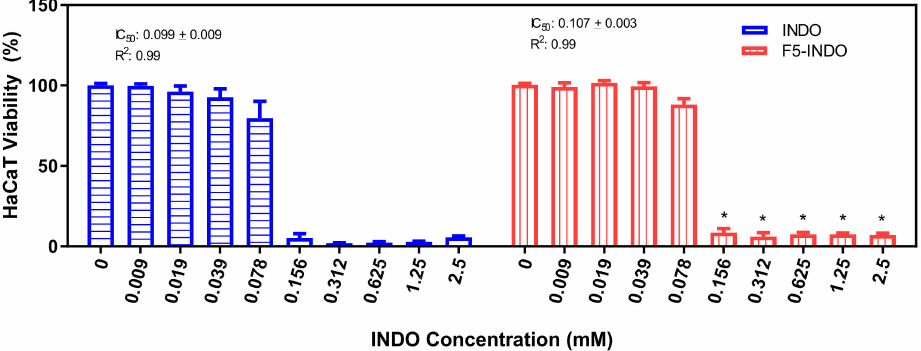
Figure 3. In vitro viability test in HaCaT cells ( n = 9). T test determined statistically significant differences between free indomethacin (INDO) and F5-INDO formulations in different concentrations, (* p <